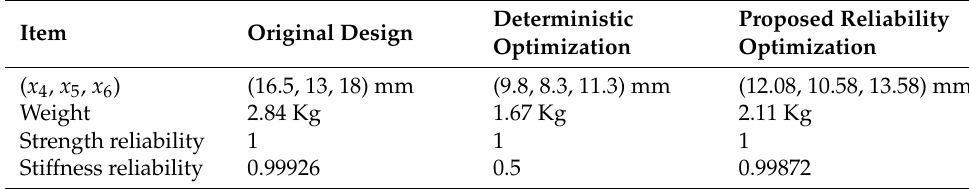
Table 5. Reliability design optimization results for the small